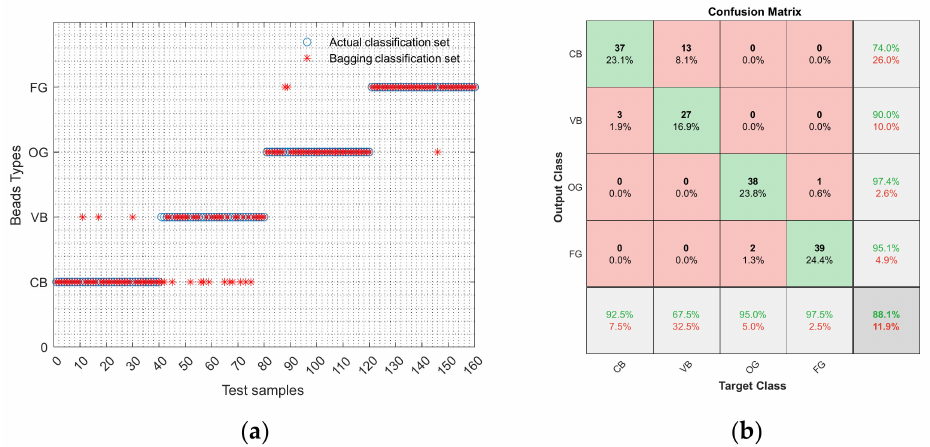
Figure 14. Identification results of bagging. Figures shown in ( a , b ) are the identification results of bagging and its confusion